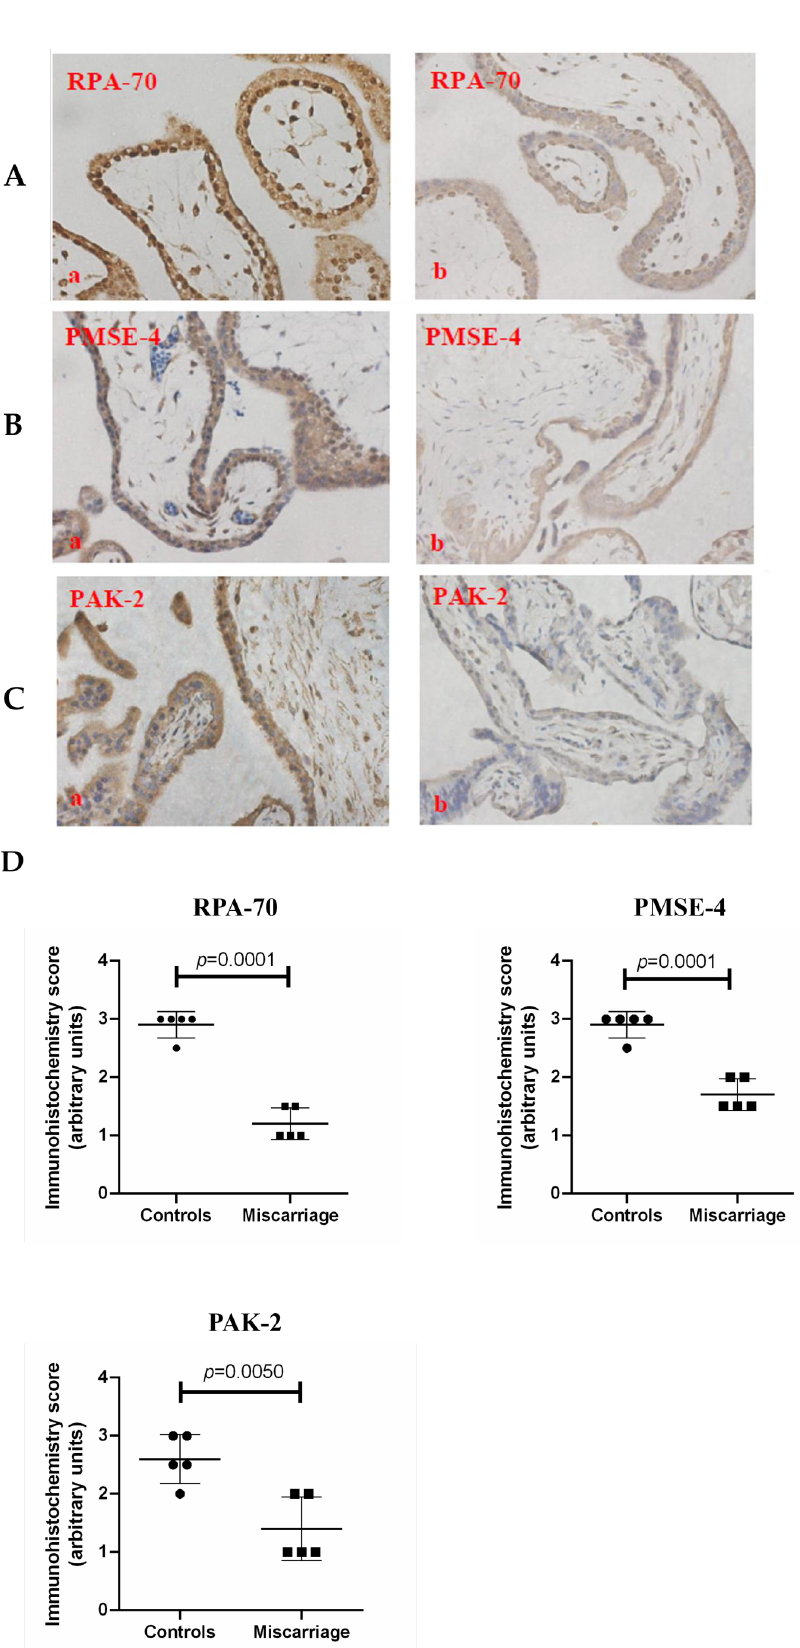
Figure 6. The representative immunohistochemistry images showing the lower expression of RPA-70 ( A ), PSME-4 ( B ), and PAK-2 ( C ) in missed-miscarriage placentae ( b ) and control placentae ( a ), measured by a semiquantitative analysis ( D ) (magnification: x400).